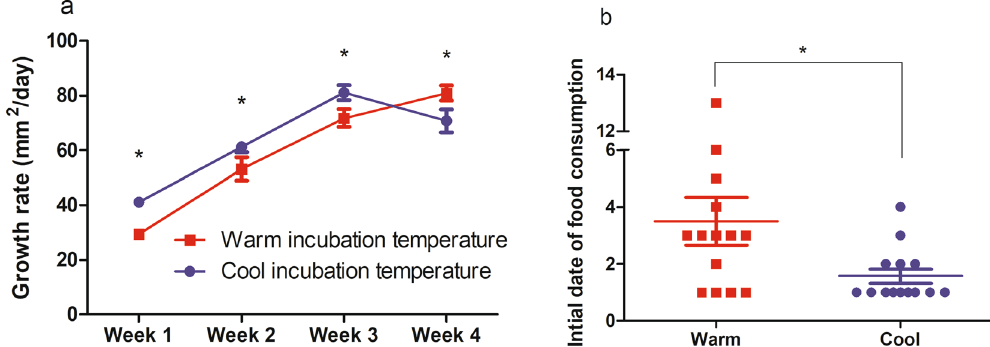
Figure 2. Growth rate and initial date of food consumption of loggerhead sea turtles (n = 14 for each group). Size index (SCL × SCW) was used for the size parameter. ( a ) Weekly change of daily growth rate between the incubation temperature groups. Results are expressed as mean ± SEM; asterisk indicates a significant difference between columns (p < 0.05). ( b ) The initial date of food consumption in the incubation temperature groups. Results are expressed as mean ± SEM; asterisk indicates a significant difference between columns (p < 0.05).